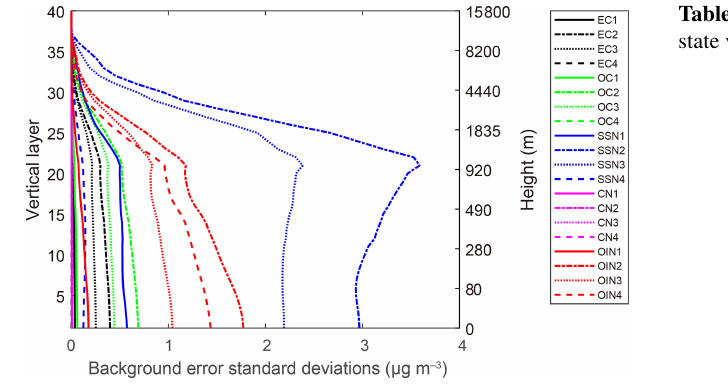
Figure 4. Vertical profiles of background error SDs in mass con- centration for aerosol control variables EC1, EC2, EC3, EC4, OC1, OC2, OC3, OC4, SSN1, SSN2, SSN3, SSN4, CN1, CN2, CN3, CN4, OIN1, OIN2, OIN3, and OIN4 in the data assimilation pro- cess, which were calculated using WRF-Chem D02 forecasts for 1 month, i.e., November 2018.